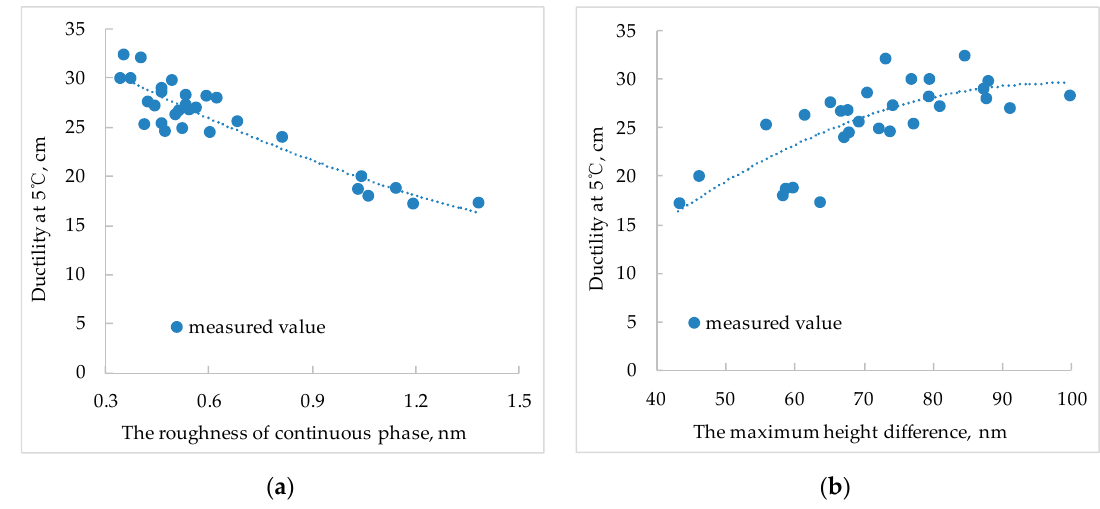
Figure 14. Relationship between the nano ‐ parameters and ductility (( a ) the roughness of continuous phase; ( b ) the maximum height difference).